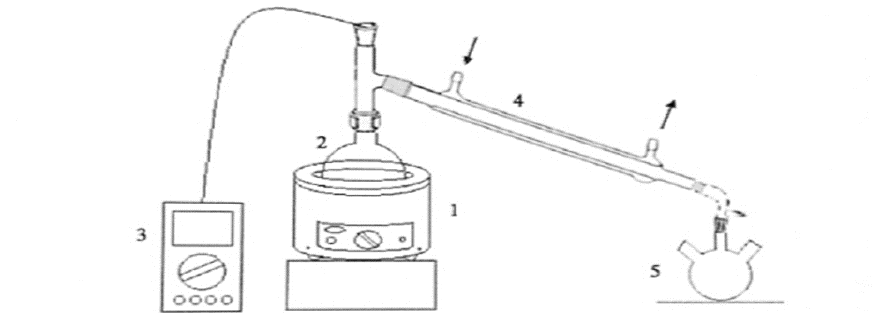
Figure 2(a): Schematic of conventional heating hydrothermal liquefaction process experimental set-up. (1) Heating mantle, (2) Round bottom flask, (3) Digital multimeter and thermocouple, (4) Liebig condenser, (5) Three necks collecting flask